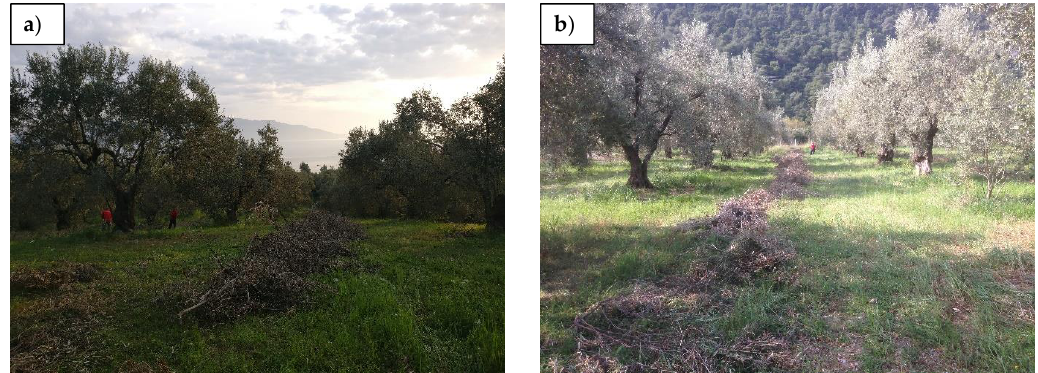
Figure 2. ( a ) Windrows on the flat slope field. ( b ) Windrows on the hilly slope field.